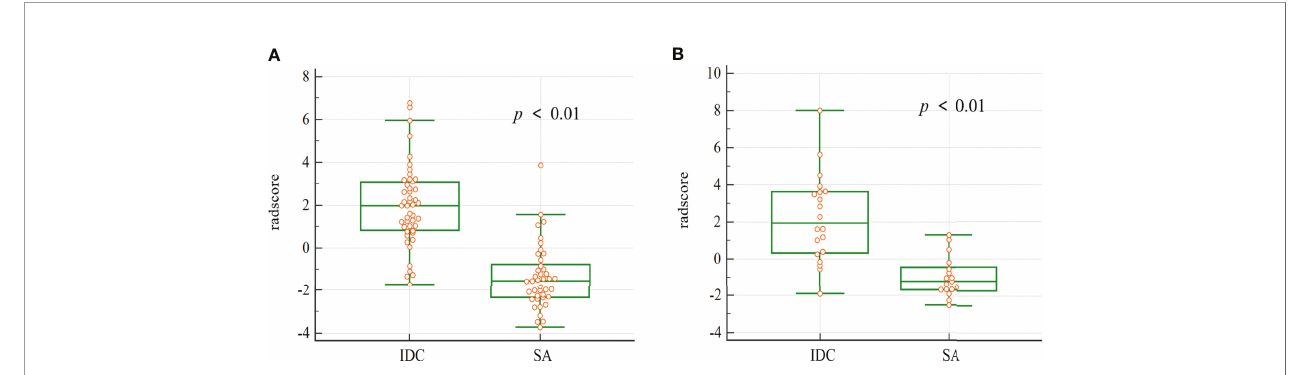
FIGURE 4 | The box plot of the radscore in the fi nal model. Mann-whitney analysis of radscore for distinguishing SA from IDC in the training cohort (A) and validation cohort (B) ( p < 0.01).